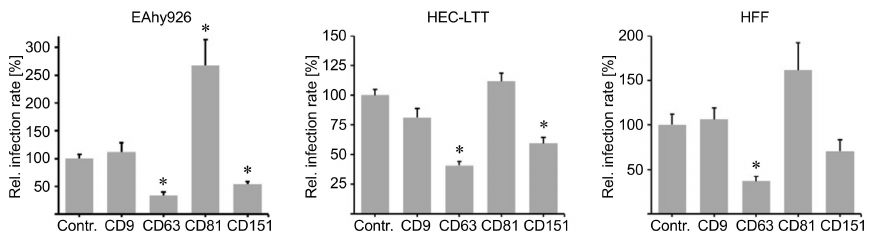
Figure 5. Blocking peptides of the cytoplasmic C-terminal tail of tetraspanins inhibit HCMV infection. EA.hy926, HEC-LTTs or HFF cells were incubated with 2 µ M scrambled control peptide (Contr.) or peptides with the C-terminal tail of CD9, CD63, CD151 for 2 h at 37 ◦ C. Afterwards, the cells were infected with the HCMV strain TB40/E and 24 h.p.i. fixed with 80% acetone. The fraction of infected cells, IE-Ag positive, was determined by immunofluorescence. The data is shown as mean ± SEM and was normalized to the mean of control peptide treated cells (set to 100%). Asterisks indicate significant differences compared to control ( p < 0.05). Graphs represent data collected from two independent experiments.